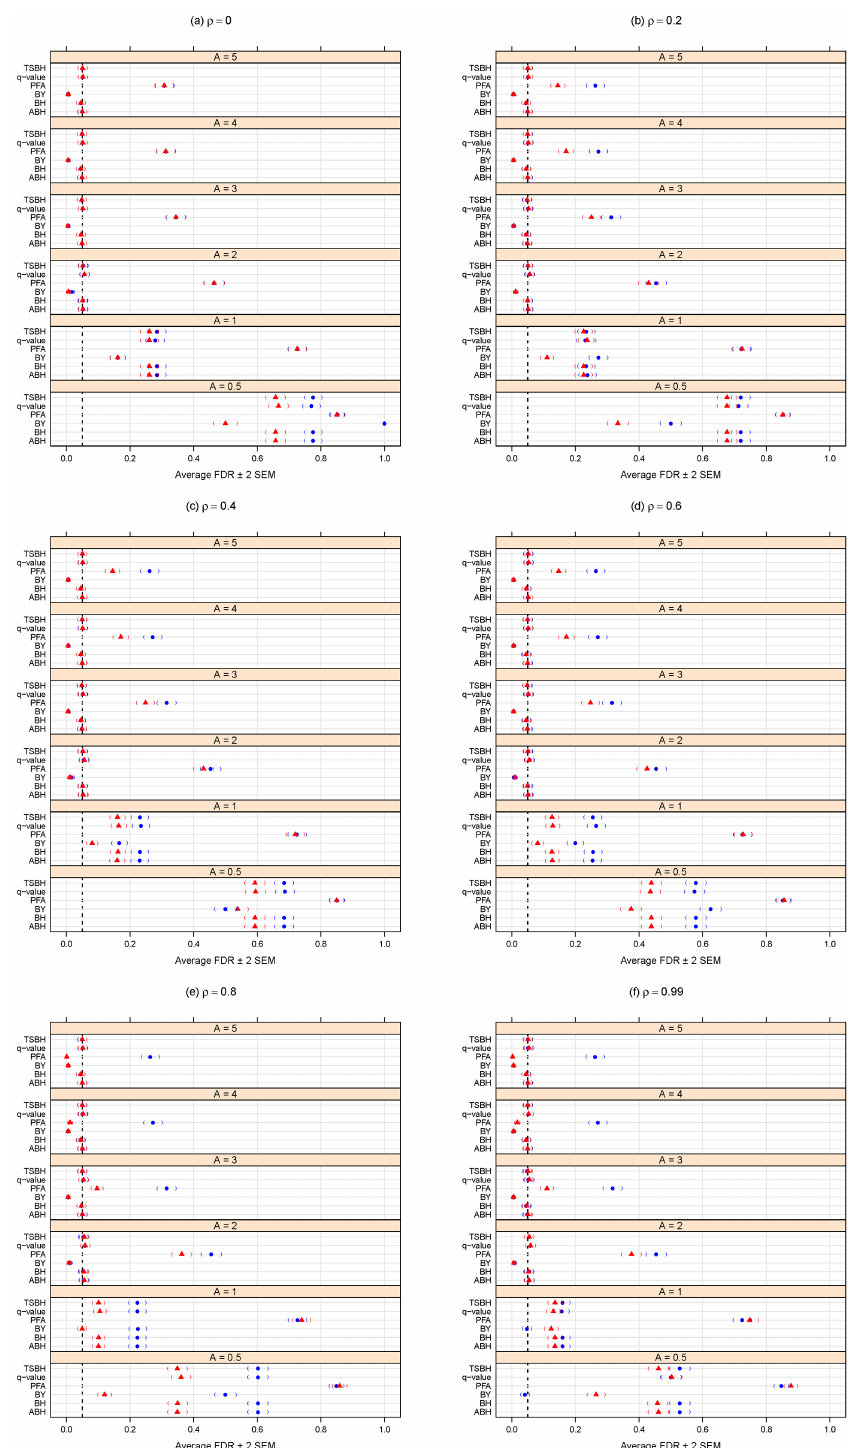
Fig 3. Average FDR for different methods purporting to control the FDR at α = 0.05. A can be thought of as the magnitude of differentialabundance for truly differentiallyabundant features, and ρ is the true correlationwithin blocks of dependent tests. The blue solid circles represent the case of 120 dependenttests (out of 2000total), whereasthe red solid trianglesare for the case of 360 dependent tests. Parentheses indicate ± 2